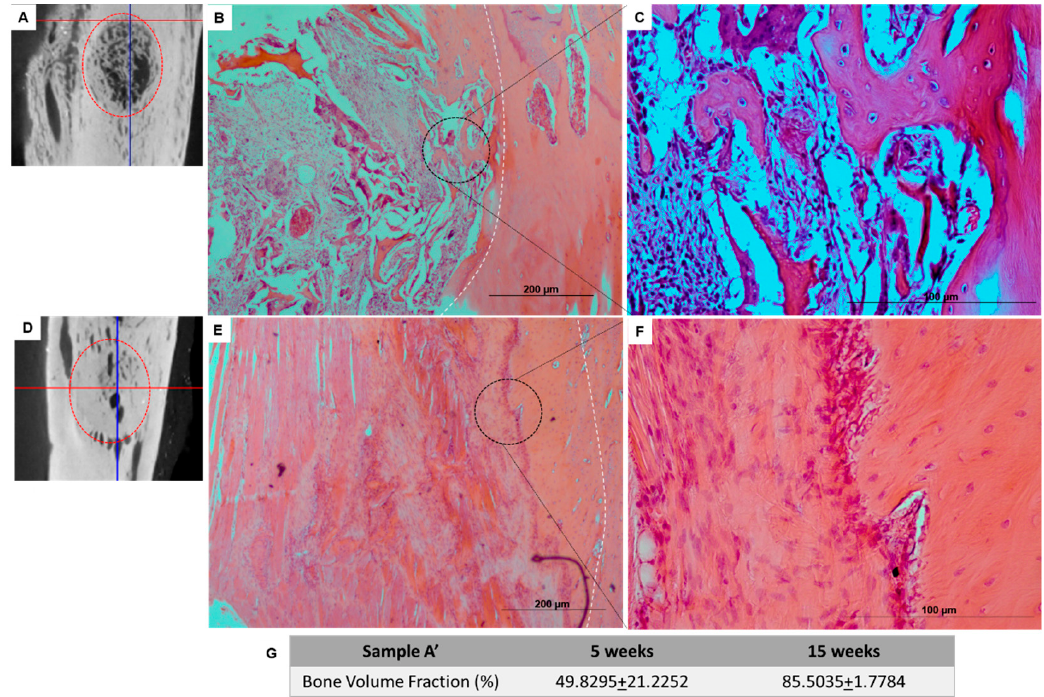
Figure 10. ( A and D ) MicroCT scan 3D reconstruction images of Coll/nanoHA implants (A’) in the bone tissue of rabbits’ tibia after 5 ( B , C ) and 15 weeks ( E , F ). ( G ) Table with the percentage of the volume fraction calculated by microCT analysis after 5 and 15 weeks.